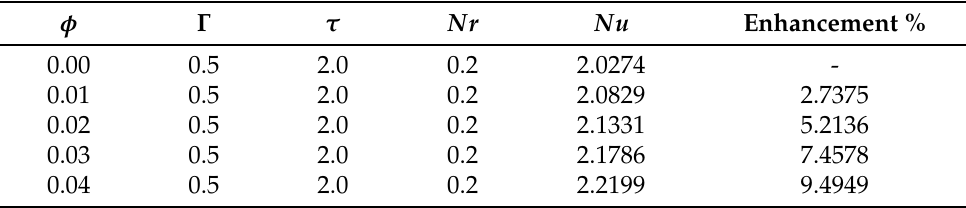
Table 4. Numerical analysis of percentage enhancement in Nusselt number due to volume fraction of nanoparticles.